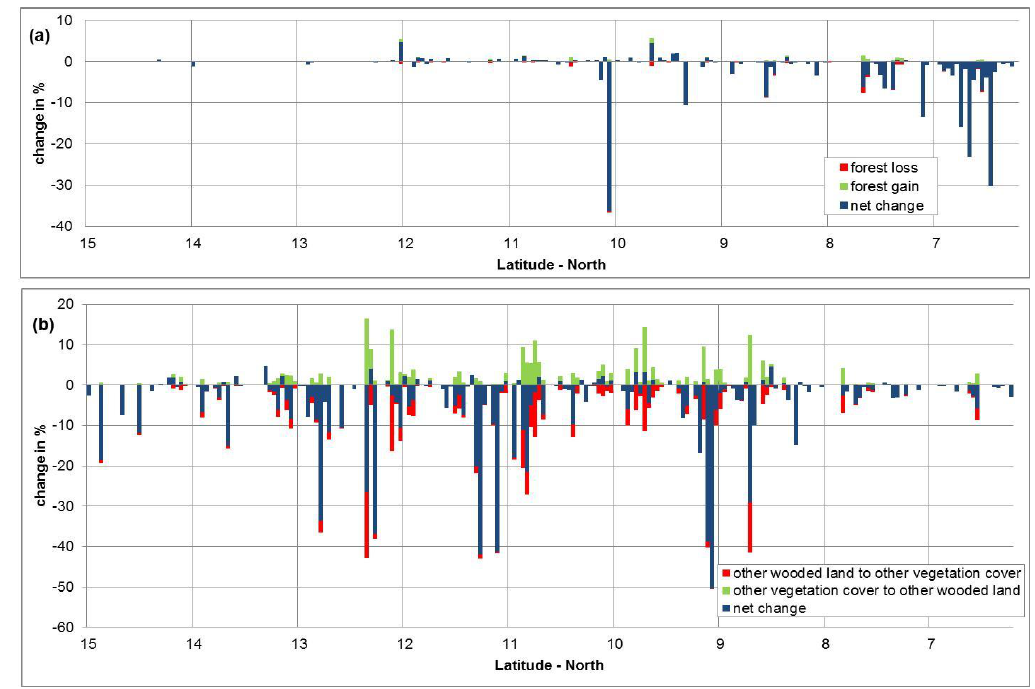
Figure 9. Loss, gain and net land cover changes for each sample site depending of its latitude and for two dynamics ( a ) forest to all other land cover classes, and ( b ) other wooded land to other vegetation